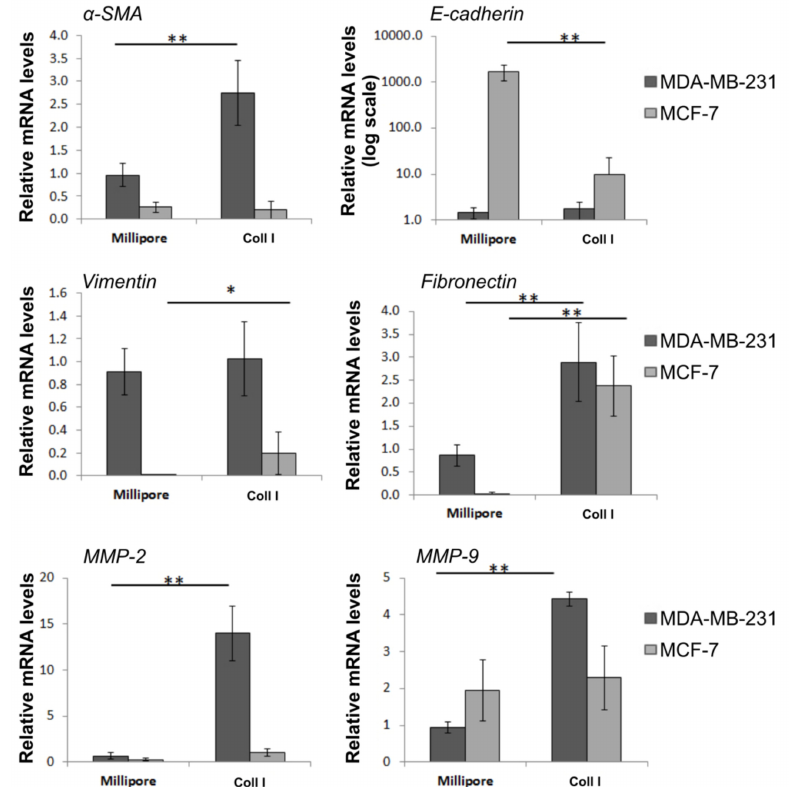
Figure 9. Type I collagen induces striking changes in EMT markers and significant alterations in the expression of ECM components of breast cancer cells. Real-time PCR analysis of a-SMA, E-cadherin, vimentin, fibronectin, MMP-2 and MMP-9 on MDA-MB-231 and MCF-7 cells seeded on uncoated Millipore filter or filter covered with collagen type I and incubated for 24 hours. Expression was normalized to GAPDH expression. Asterisks (*), (**) indicate statistically significant differences ( p ≤ 0.05 and p ≤ 0.01,